Question: Does the plotted quantity increase or decrease?
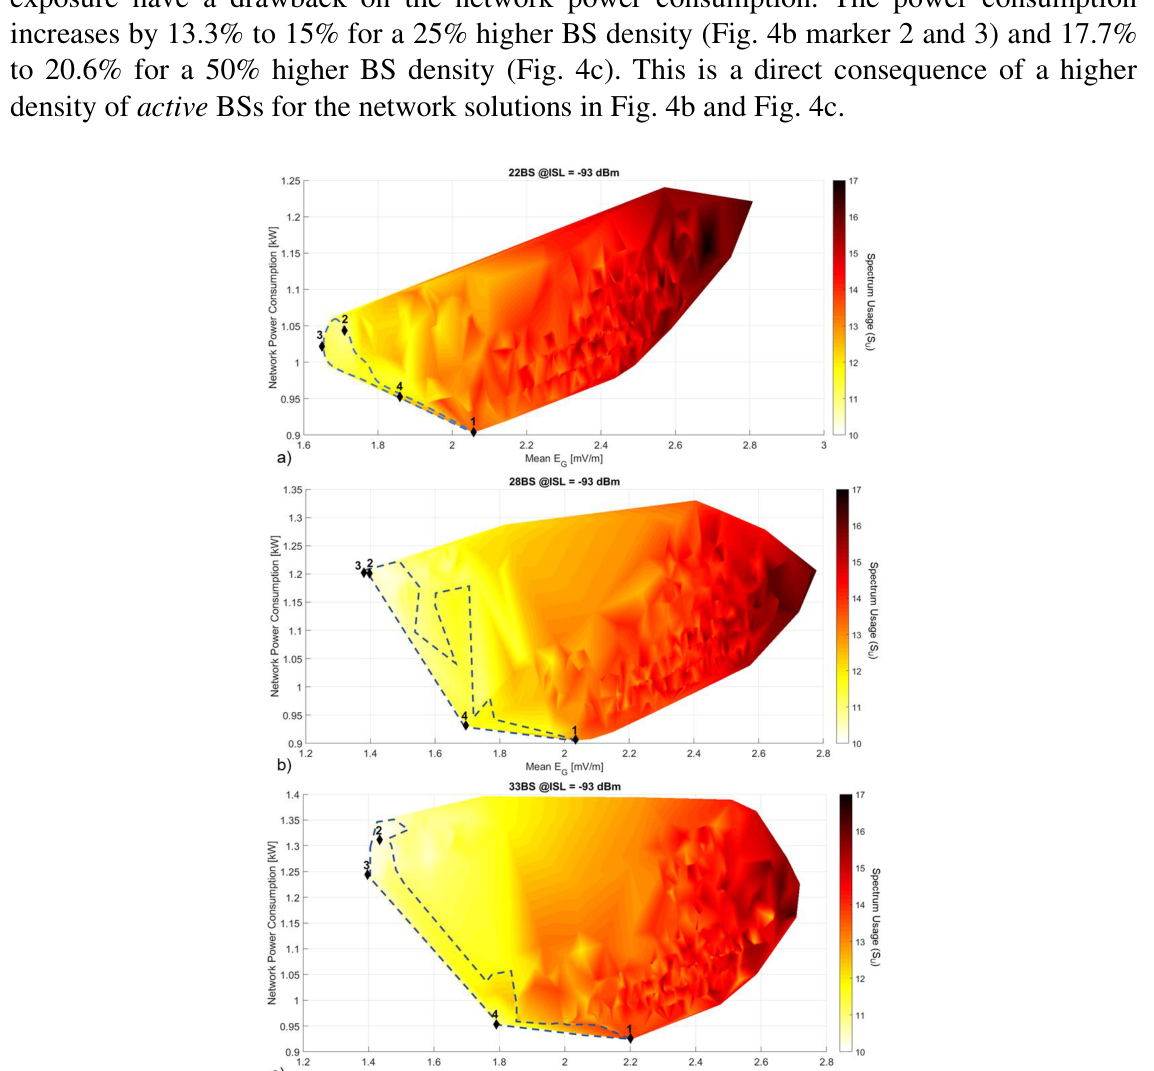
Answer: increasing